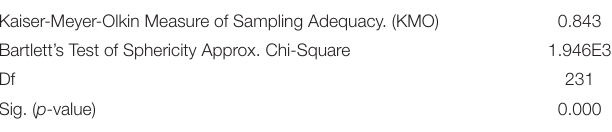
TABLE 6 | Item sufficiency and sampling adequacy